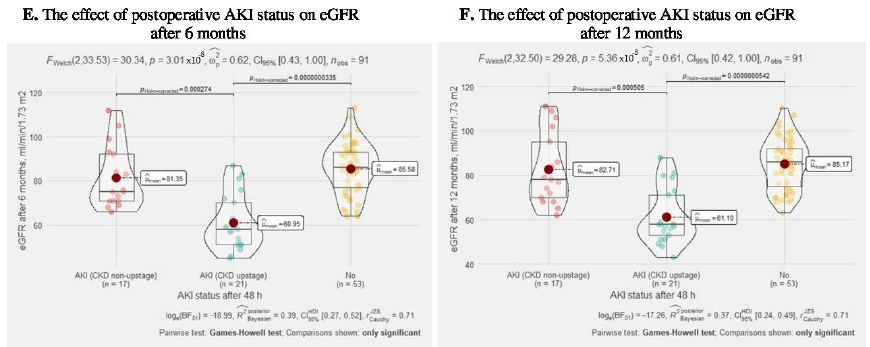
Figure 6. The effect of postoperative renal function on eGFR. Welch’s t -test revealed that, across 91 patients, although the eGFR after 6 months, mL/min/1.73 m 2 : ( A )—were lower in AKI group after 48 h, as compared to non − AKI group. This effect was statistically significant. The effect size (g = − 1.08), ( p < 0.0001) was high, as per Cohen’s (1988) conventions. The Bayes Factor for the same analysis revealed that the data were 15 times more probable that the means are different as compared to the null hypothesis, that the means are equal; ( C )—were lower in postoperative renal dysfunction group, as compared to non − dysfunction group. This effect was statistically significant. The effect size (g = − 1.87), ( p < 0.0001) was high, as per Cohen’s (1988) conventions. The Bayes Factor is 23; ( E )—were lower in AKI with CKD upstage group after 48 h, as compared to non − AKI and AKI without CKD upstage groups. This effect was statistically significant. The effect size (g = − 0.62), ( p < 0.0001) was high. Welch’s t -test revealed that, across 91 patients, although the eGFR after 12 months, mL/min/1.73 m 2 : ( B )—were lower in AKI group after 48 h, as compared to non − AKI group. This effect was statistically significant. The effect size (g = − 0.95), ( p < 0.0001) was high. The Bayes Factor is 13; ( D )—were lower in postoperative renal dysfunction group, as compared to non − dysfunction group. This effect was statistically significant. The effect size (g = − 1.83), ( p < 0.0001) was high, as per Cohen’s (1988) conventions. The Bayes Factor is 23; ( F )—were lower in AKI with CKD upstage group after 48 h, as compared to non − AKI and AKI without CKD upstage groups. This effect was statistically significant. The effect size (g = − 0.62), ( p < 0.0001) was